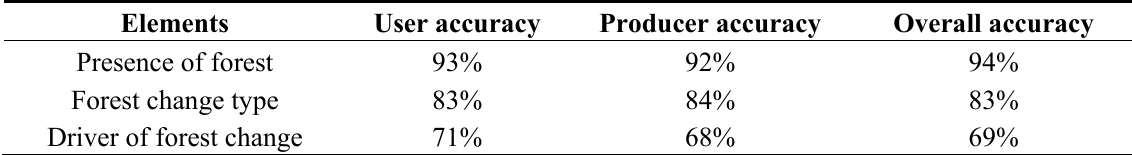
Table 7. Accuracy assessment of local expert data compared to field-based reference dataset in the thematic